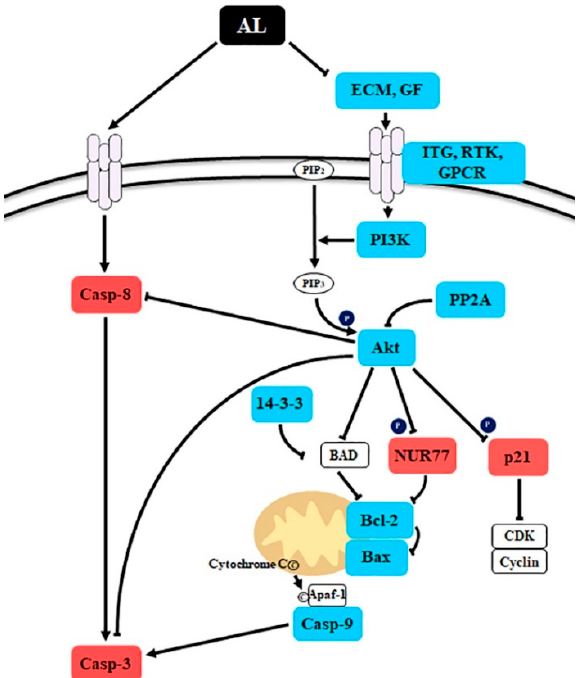
Figure 5. Schematic presentation of the probable molecular mechanism of Abeliophyllum distichum leaves extract (AL)-induced cell death. The red and blue boxes indicate the up- and down-regulated genes by AL treatment in SK-MEL-2 cells.